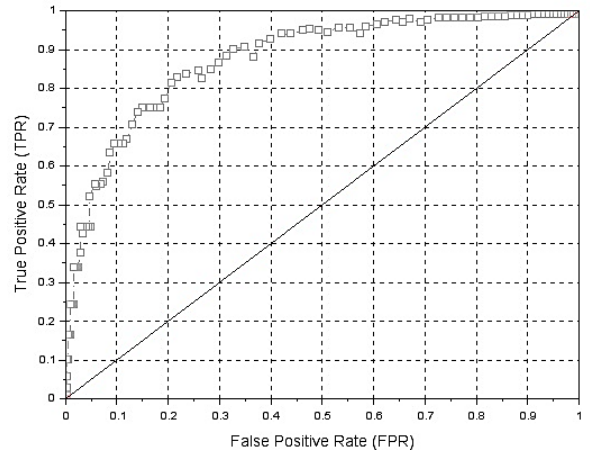
Figure 8: ROC curve for the split defect detection